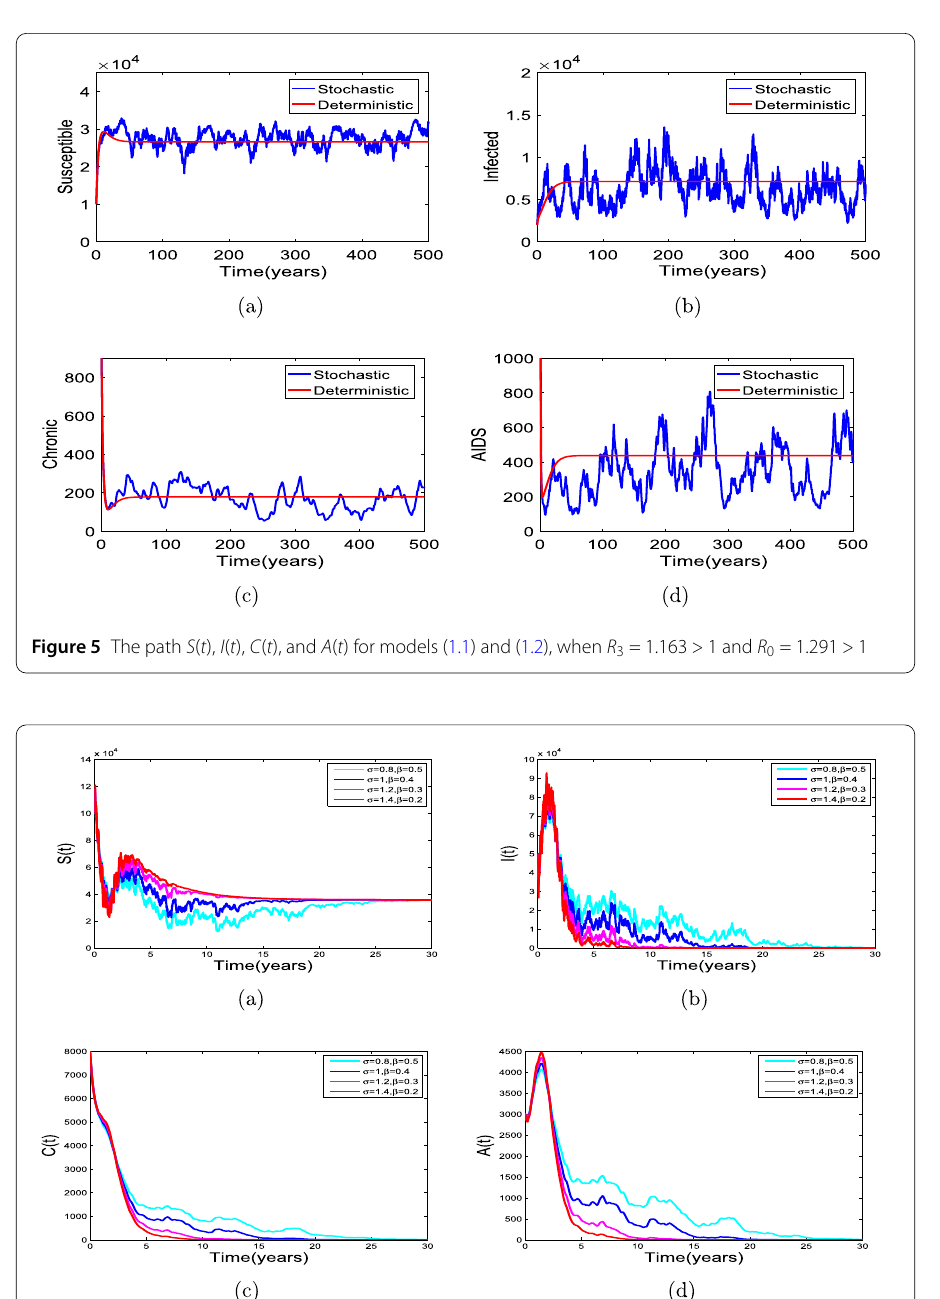
orem 3.1 and Fig. 1 and Fig. 2). Furthermore, lim t → + ∞ S ( t ) = λ (see Theorem 3.1), but for μ the corresponding deterministic model (1.2), R 0 > 1, there exists an endemic equilibrium, which means that a stochastic perturbation can suppress the outbreak of the disease (see Fig. 1 and Fig. 2), and the bigger the intensity of the random perturbation, the faster the disease dies out (see Fig. 3). However, deterministic models do not take this into account, so it is essential to include a stochastic element in deterministic models. In addition, we